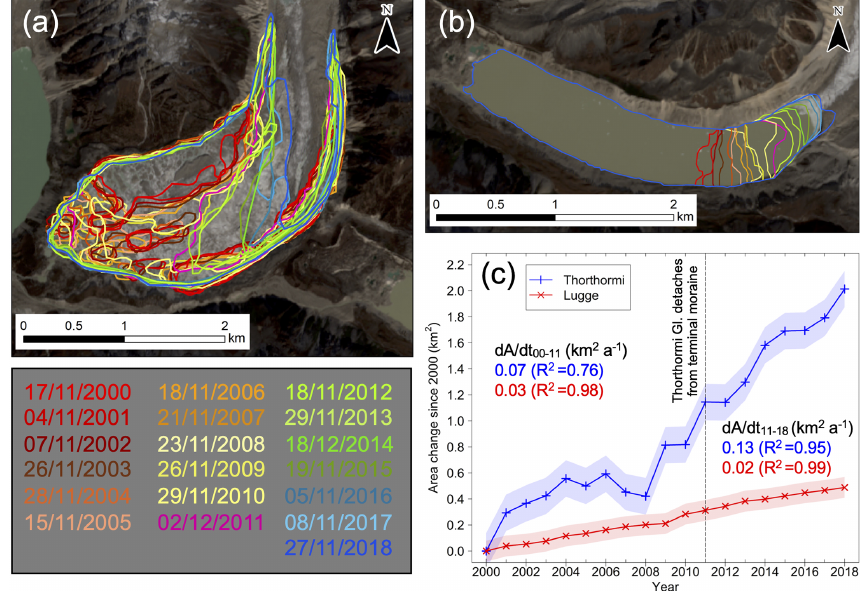
Figure 2. Temporal variations in the spatial extents of (a) Thorthormi and (b) Lugge proglacial lakes. (c) Cumulative changes in lake area for Thorthormi and Lugge glaciers relative to 2000. The background images in (a) and (b) are Sentinel-2 satellite images that were acquired on 11 November 2017. The 2000–2011 lake outlines are from Tsutaki et al. (2019). The d A/ d t values in (c) are the 2000–2011 (upper left) and 2011–2018 (lower right) lake expansion rates. Table 1. Comparison of the measured surface elevation change rates of Thorthormi and Lugge glaciers from various